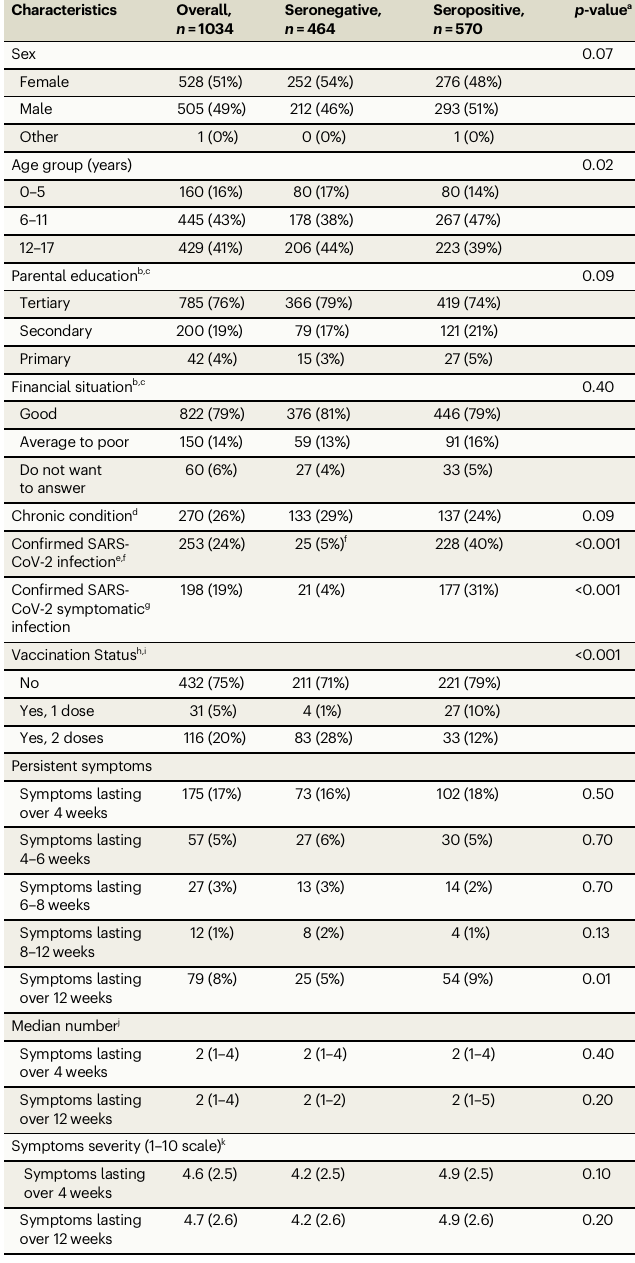
Table 1 | Descriptive statistics